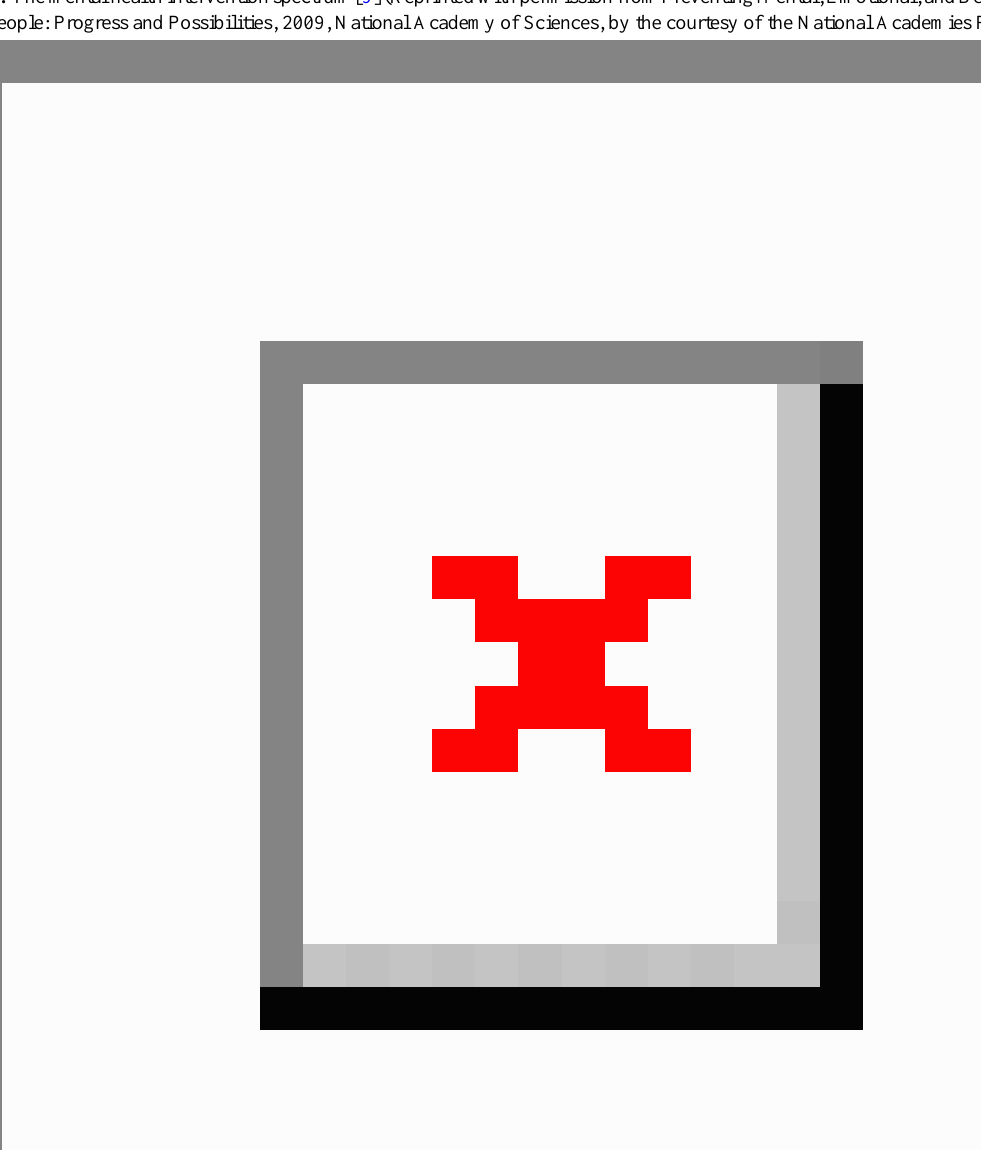
Figure 1. The mental health intervention spectrum [9] (Reprinted with permission from Preventing Mental, Emotional, and Behavioral Disorders